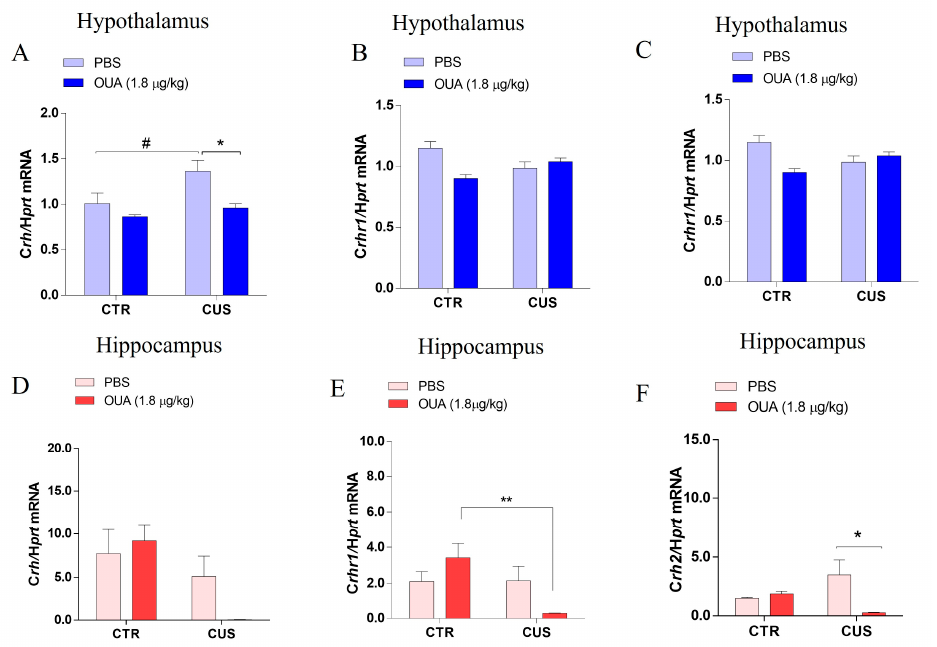
Figure 6. Decreased expression of Crh mRNA and their receptors in the hippocampus and hy- pothalamus of stressed rats and treated with ouabain. ( A – C ) Expression of Crh mRNA ( n = 6–10) (F (1, 30) = 8.754; p = 0.0060 for CUS factor; F (1, 30) = 12.83; p = 0.0012 for treatment factor), # p < 0.05 when compared with CTR x CUS and * p < 0.05 when compared with CTR-CUS x CUS+OUA, Crhr1 mRNA ( n = 8–10) (F (1, 34) = 0.08910; p = 0.7671 for CUS factor. F (1, 34) = 5.311; p = 0.0274 for treat- ment factor), and Crhr2 mRNA ( n = 8–10) (F (1, 32) = 3.165; p = 0.0847 for CUS factor. F (1, 32) = 6.005; p = 0.0199 for treatment factor), * p < 0.05 when compared with CTR-OUA x CUS+OUA and # p < 0.05 when compared with CRT-CUS x CUS+OUA in the hypothalamus (blue bars). ( D – F ) Expression of Crh mRNA ( n = 8–10) (F (1, 32) = 8.804; p = 0.0056 for CUS factor. F (1, 32) = 0.8223; p = 0.3713 for treatment factor), Crfr1 mRNA ( n = 8–10) (F (1, 34) = 5.795; p = 0.0216 for CUS factor. F (1, 34) = 0.1837; p = 0.6709 for treatment factor), ** p < 0.01 when compared with CTR-OUA x CUS+OUA and Crhr2 mRNA ( n = 8–10) (F (1, 30) = 0.03086; p = 0.8617 for CUS factor. F (1, 30) = 3.609; p = 0.0671 for treatment factor), * p < 0.05 when compared CTR-CUS x CUS+OUA in the hippocampus (red bars). Data are presented as mean ± SEM (a two-way ANOVA, followed by Newman–Keuls post hoc test, revealed a